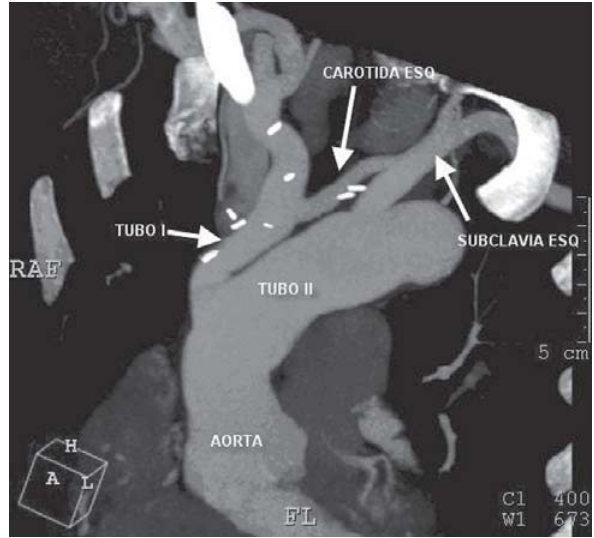
Fig. 3 - Estudo angiotomográfico de 1 ano de pós-operatório